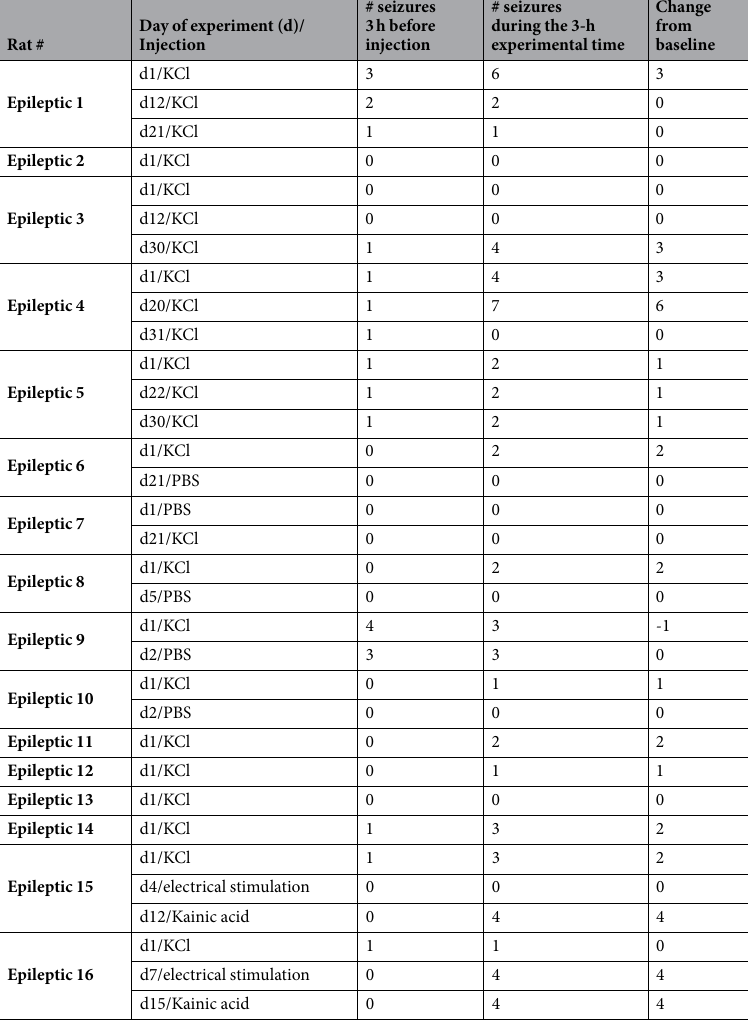
Table 1. Experimental design. Detailed schedule of KCl or PBS injections into each epileptic animal. ‘D1’ is 15 days after implantation. All the animals were monitored for up to 48 h by continuous video/EEG recording before the experimental day, starting 13 days after the surgery. Once the ninth administration was completed and the injection cannula was removed from the guide cannula, the animals remained connected to the video/ EEG recording one more day. All the experiments were performed under the same experimental protocol design. 13/16 epileptic animals had seizures during the KCl (120 mM) microinjections into nucleus reuniens. In total, seizures were observed in 18/24 individual KCl injections. The last column shows the individual changes (# of seizures) during the 3-h experimental time. No seizures were induced in the twelve control animals evaluated (data not